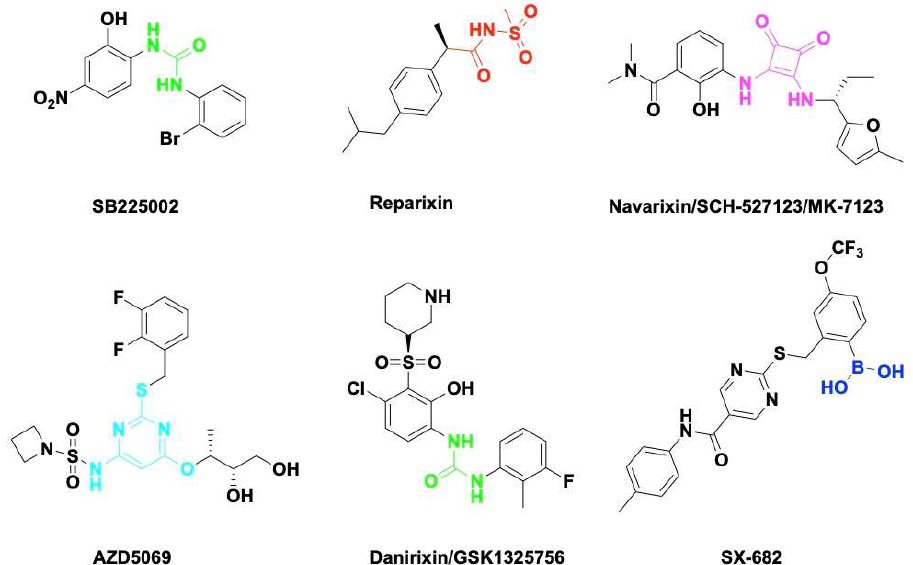
Figure 3. Small molecule antagonists targeting CXCR1/2. Blocking CXCR1 or CXCR2 impairs im- mune suppressive cell recruitment and angiogenesis to enhance cancer therapy